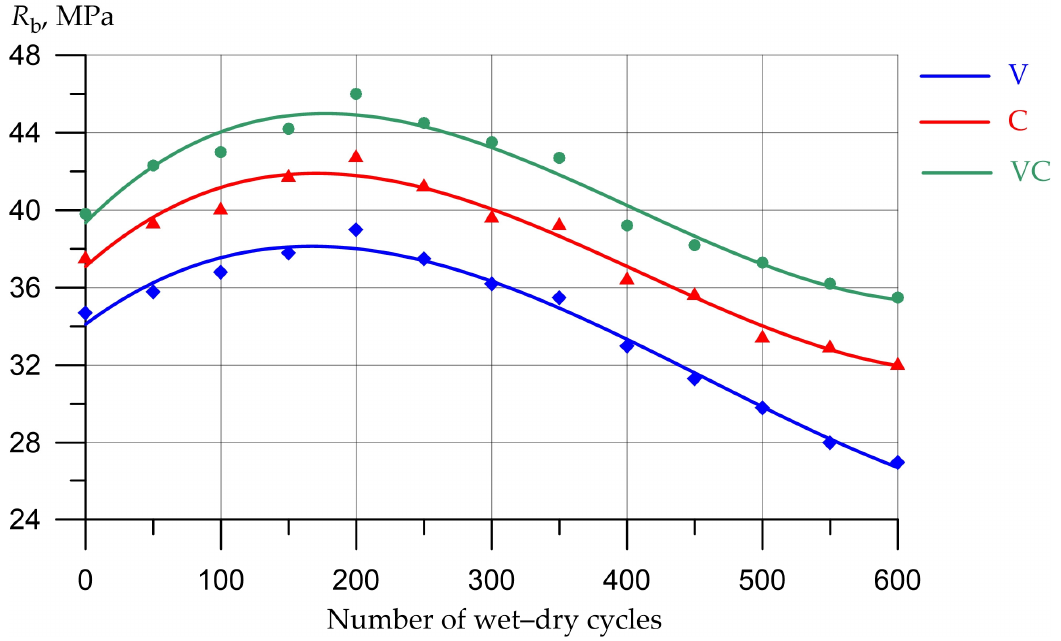
Figure 7. The dependence of the change in the prism compressive strength of vibrated, centrifuged, and vibrocentrifuged concretes on the number of “moisturizing-drying” cycles at pH